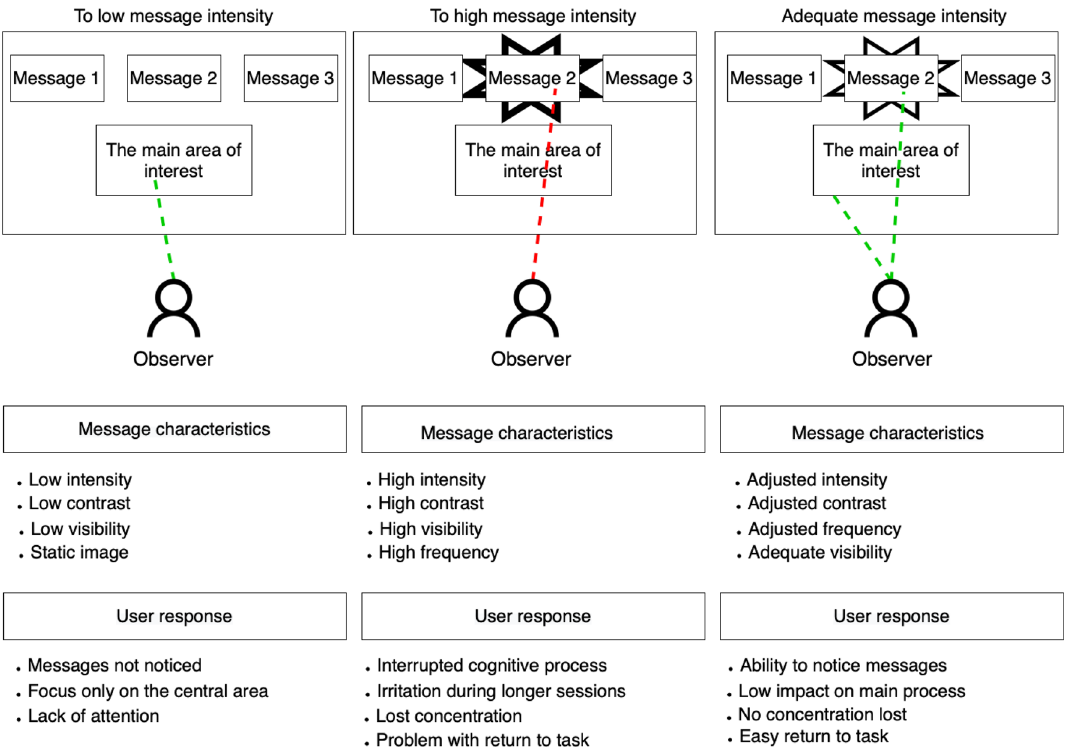
Figure 1. Interface variants with different visual intensities of presented messages in peripheral areas and the impact on the system user for low (Left), high (Middle), and target goal (Right)—adequate message